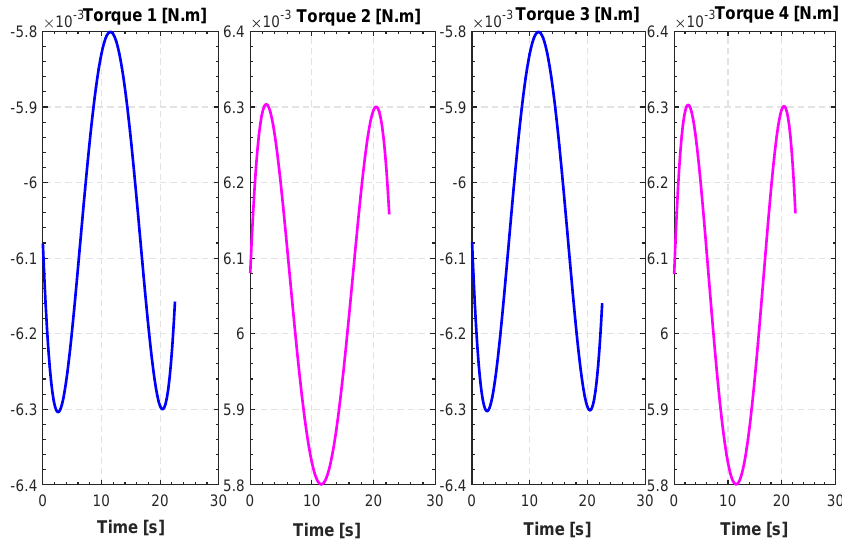
Figure 16. Evolution of actuators torques for TML.